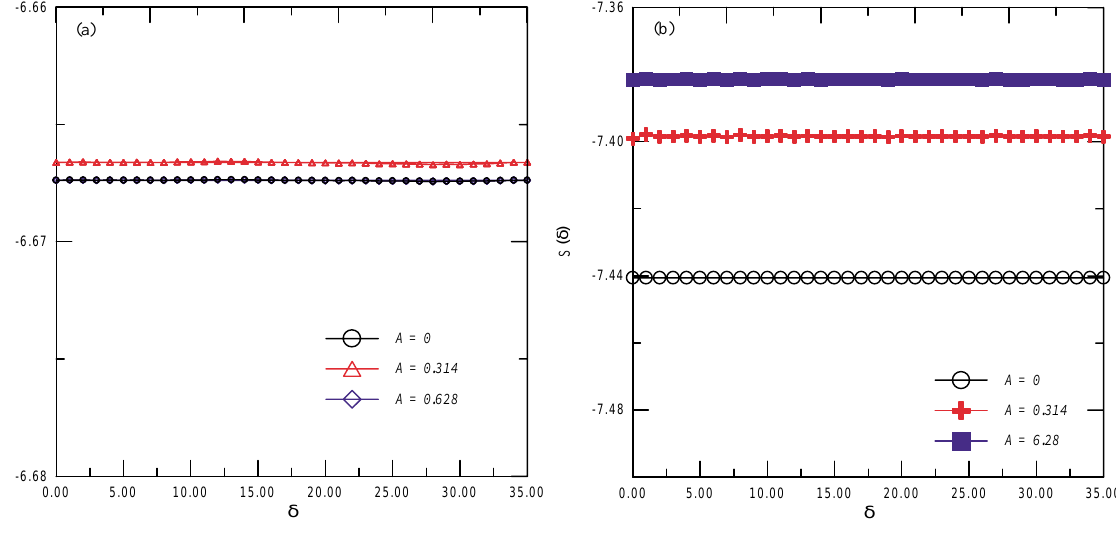
Fig. 9. Periodic signal. (a) Kantz; (b) Rosenstein et al.